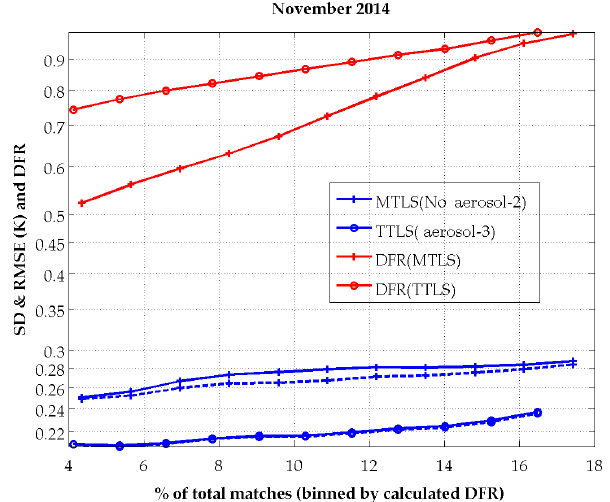
Figure 6. Comparison of retrieval accuracy (blue lines) and al- gorithm sensitivity (degrees of freedom in retrieval; red lines) of MTLS (plus) without aerosol and truncated total least squares (solid circles) using aerosol optical depth in the state vector for MODIS- Aqua data for January 2015. Evaluation is done against i Quam buoy data.